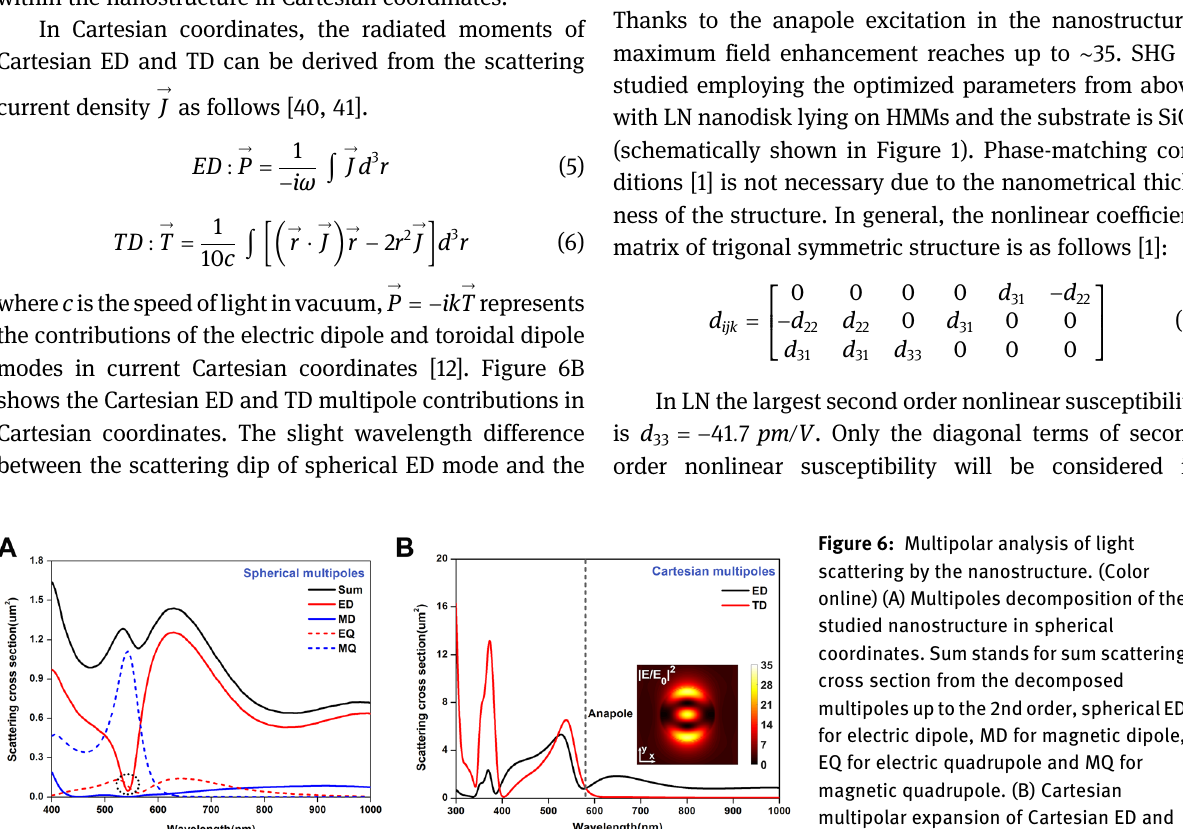
indicatesthewavelengthofthedestructivelyinterferenceasthefirst-orderanapoleexcitation.Theinsetshowstheelectricfielddistributionat the first-order anapole